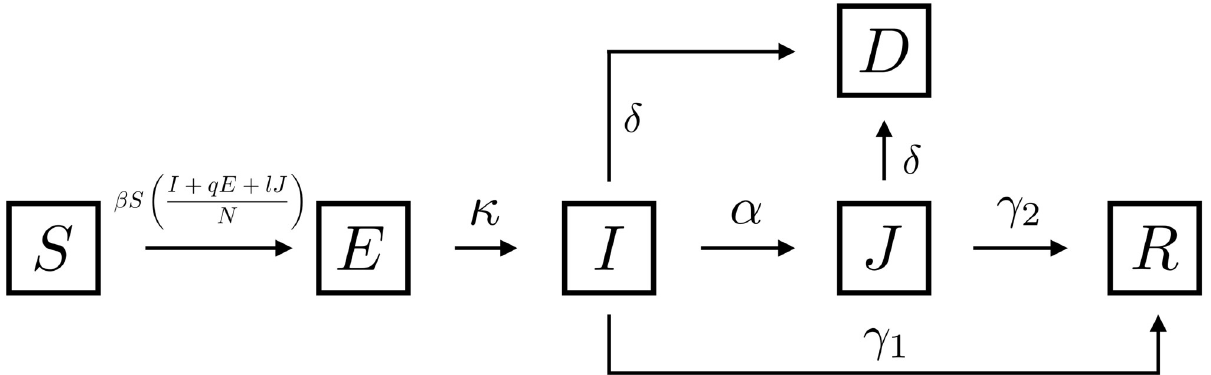
Fig 1. Single community COVID-19 disease dynamics. The rates associated with the pathways are included in Table 1.